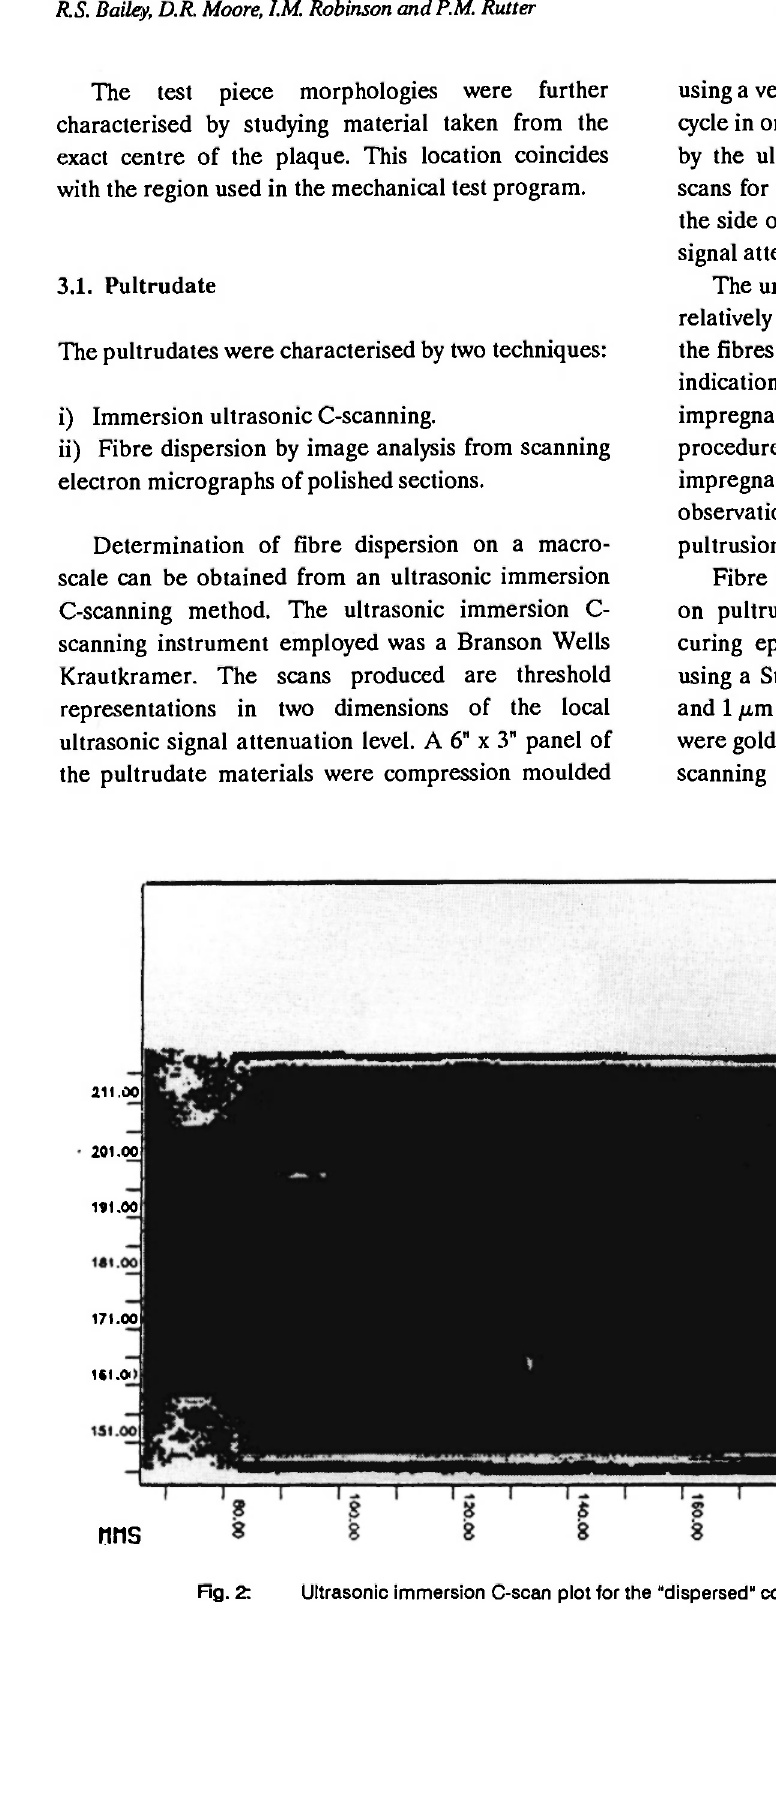
Fig. 2: Ultrasonic immersion C-scan plot for the "dispersed" compression moulded pultruded